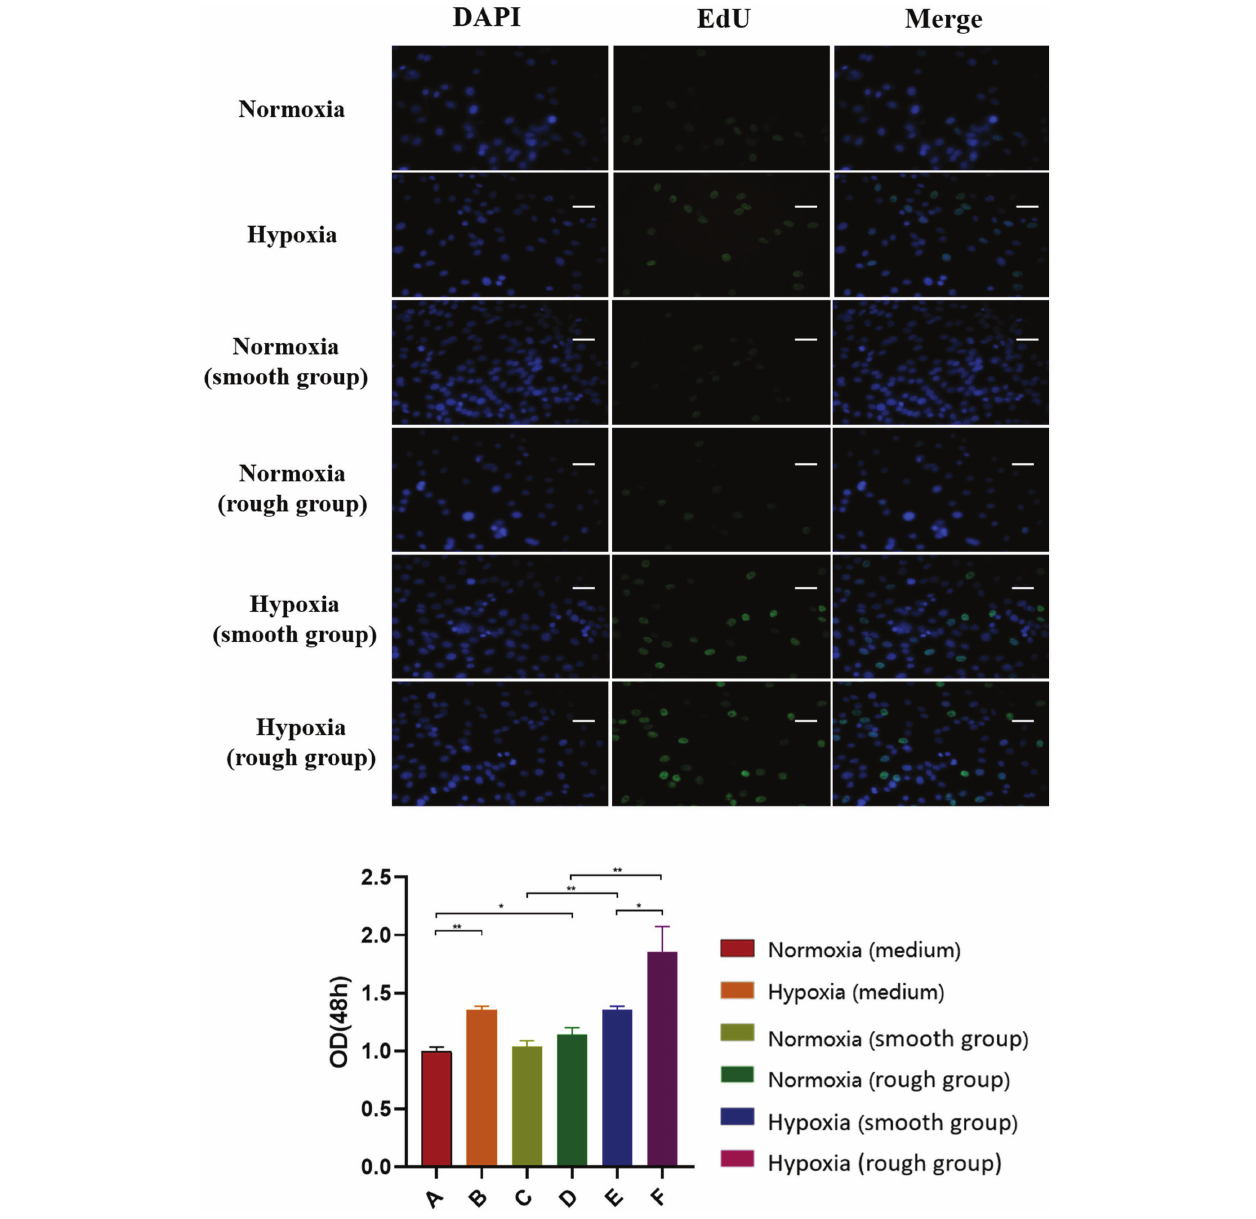
FIGURE 3 | EdU staining results for the different groups. The EdU staining results and quantification of different groups under different environment [Blue: 4,6-diamidino-2-phenylindole (DAPI), Green: EdU]. Scale bar = 200 μ m. * p < 0.05, ** p <